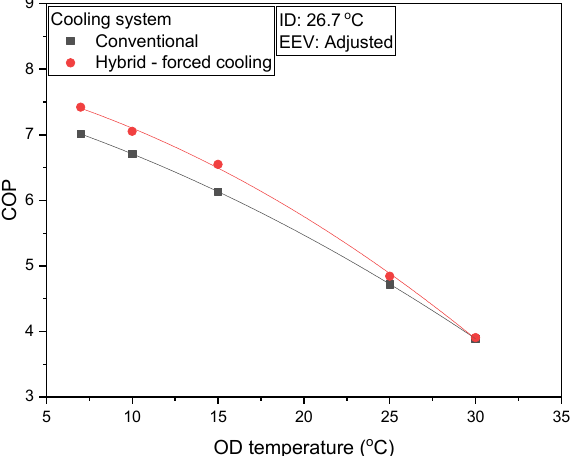
Figure 12. COP comparison for novel hybrid IDC cooling and conventional IDC cooling system.